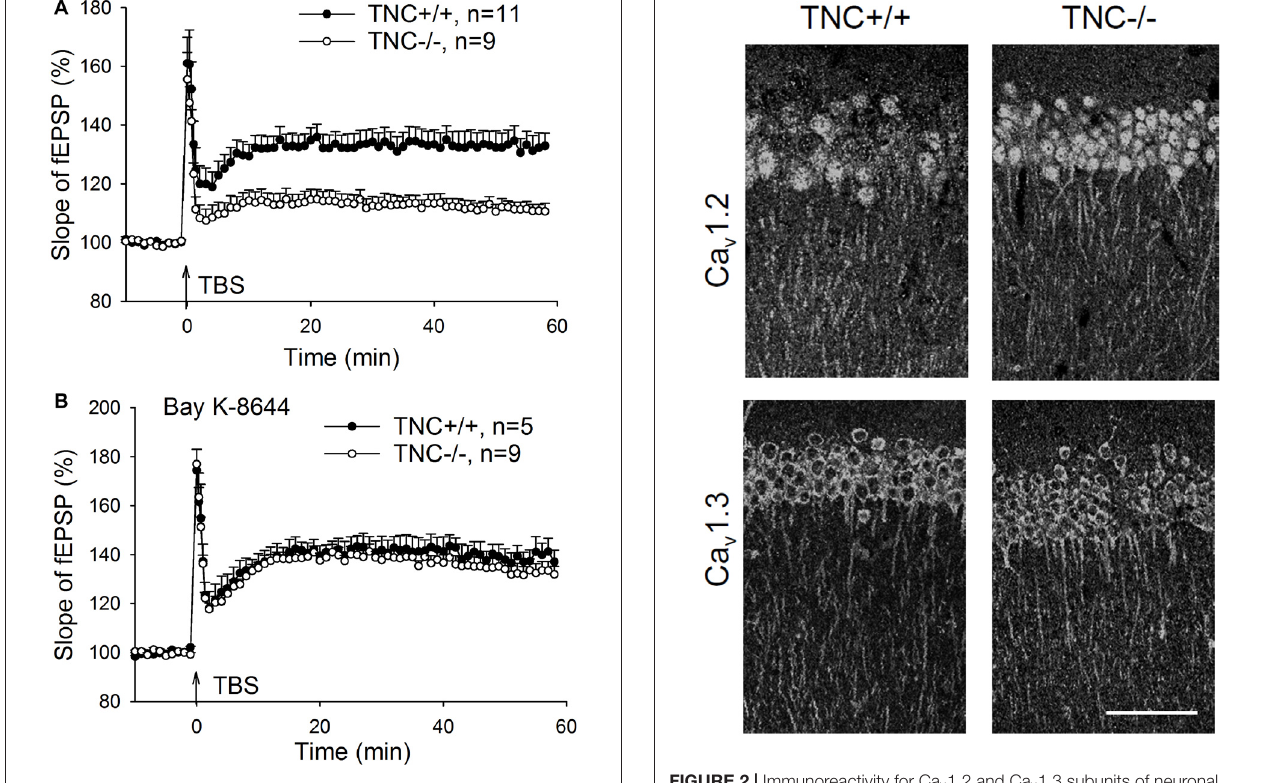
FIGURE 1 | Restoration of CA1 long-term potentiation (LTP) in tenascin-C (TNC − / − ) mice by the L-type voltage-gated Ca 2 + channel (L-VGCC) activator Bay K-8644. (A) Four trains of theta-burst stimulation (TBS) of Schaffer collateral/commissural fibers induced impaired LTP in the CA1 region of TNC − / − mice. (B) LTP in TNC − / − mice can be restored to wild-type levels by the L-VGCC activator Bay K-8644 (10 µ M). Mean and SEM values are shown, the mean slope of field excitatory postsynaptic potentials (fEPSPs) recorded 10 min before the induction of LTP was set to 100%.